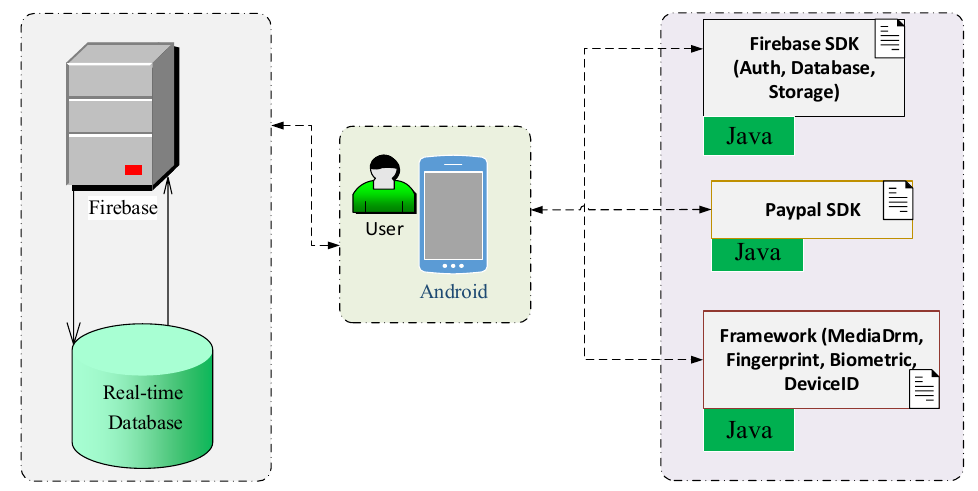
Figure 4. Component diagram of the proposed method.